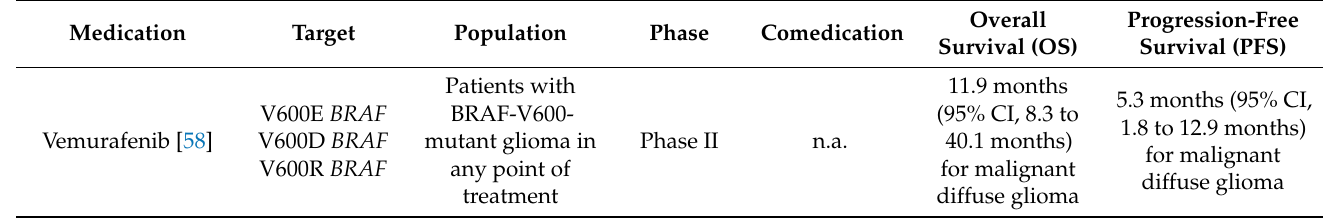
Table 1. Targeted therapies in glioblastoma, currently under clinical trial or